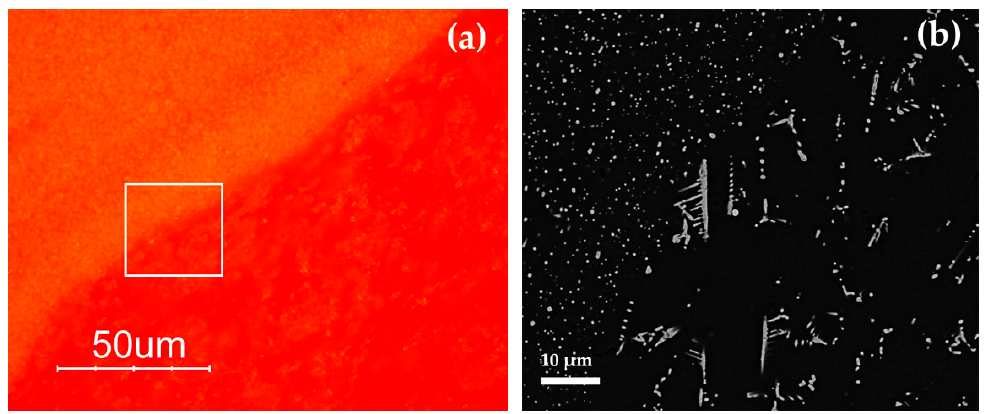
Figure 18. Optical ( a ) and FEG–SEM micrographs ( b ) of the red layer and orange layer in sample AR4 (Gr-5).